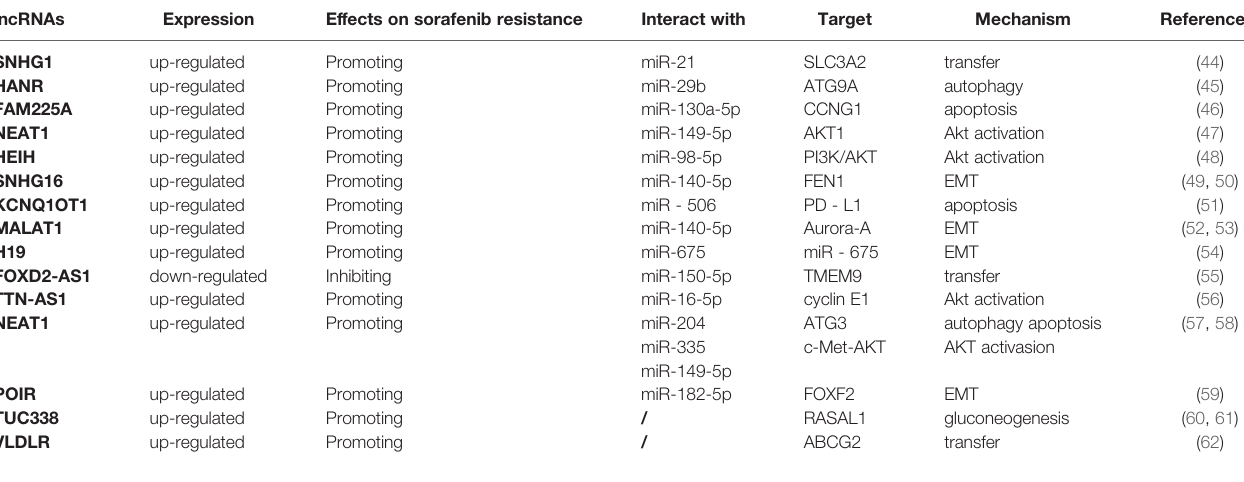
TABLE 2 | lncRNAs and sorafenib resistance in